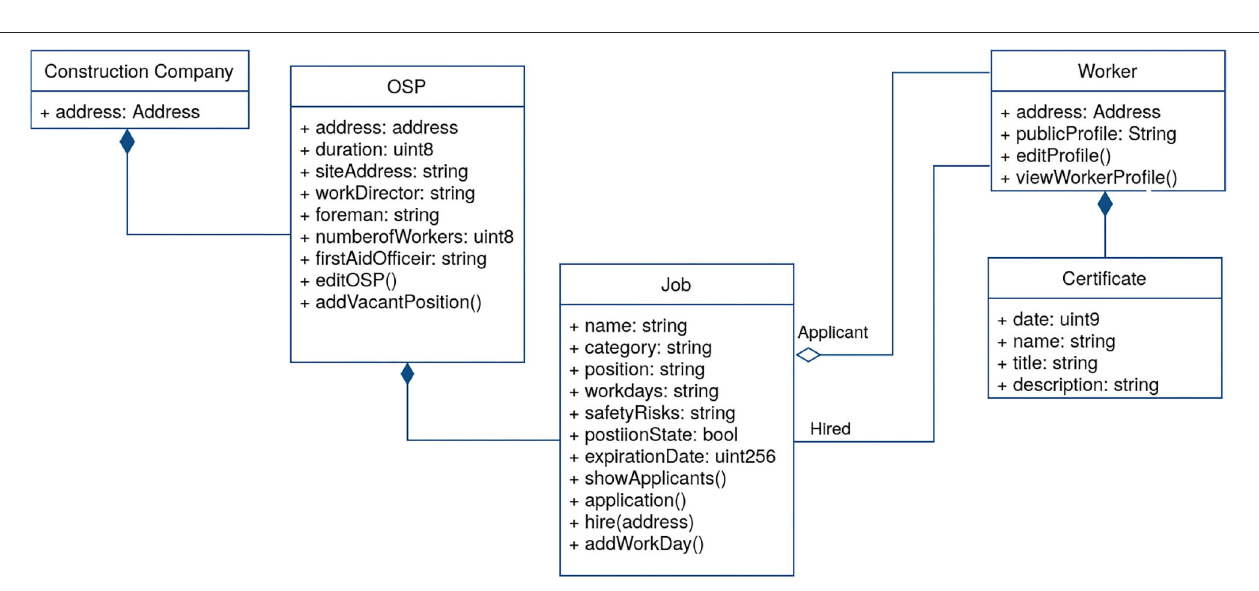
essential data and public functions of classes and represents the interconnections between system